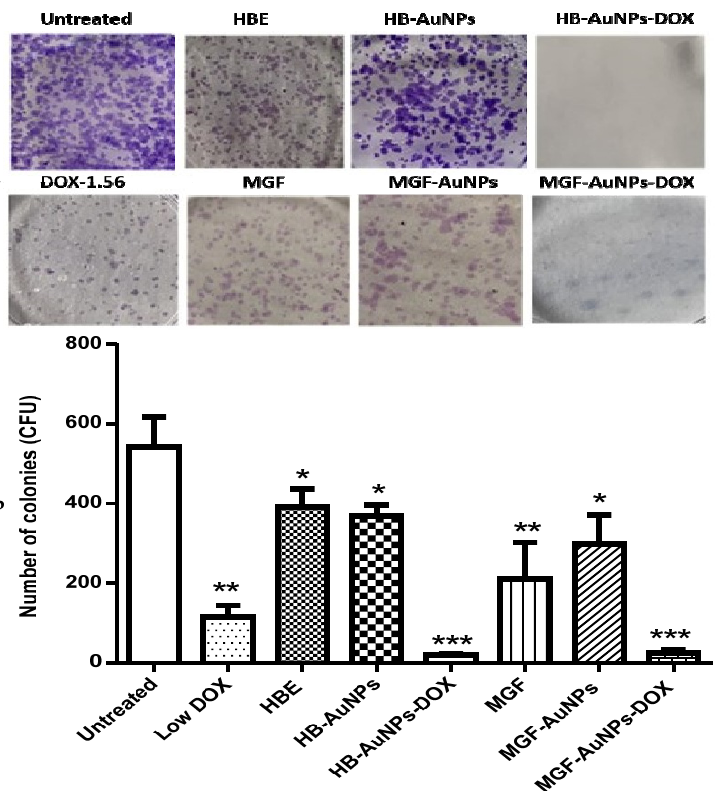
Figure 7. Effects of treatments on the long-term survival of Caco-2 cells. The clonogenic assay was used to assess the effects of Low DOX (1.56 µ g/mL), MGF (1000 µ g/mL), HBE (1000 µ g/mL), MGF-AuNPs (1000 µ g/mL), HB-AuNPs (1000 µ g/mL), MGF-AuNPs-DOX (1000 µ g/mL MGF-AuNPs and 1.56 µ g/mL DOX) and HB-AuNPs-DOX (1000 µ g/mL HB-AuNPs and 1.56 µ g/mL DOX) on the long-term survival of the cells. After a 24 h treatment, cells were cultured in medium without treatments for 14 days. Surviving cells were stained crystal violet; ( a ) shows images of the colonies (in blue) that were present after 14 days; ( b ) shows a summary of the colonies counted. Results are expressed as mean ± standard error of the mean (SEM). Data were considered statistically significant if p < 0.05, *** p < 0.001, ** p < 0.01, * p < 0.05.